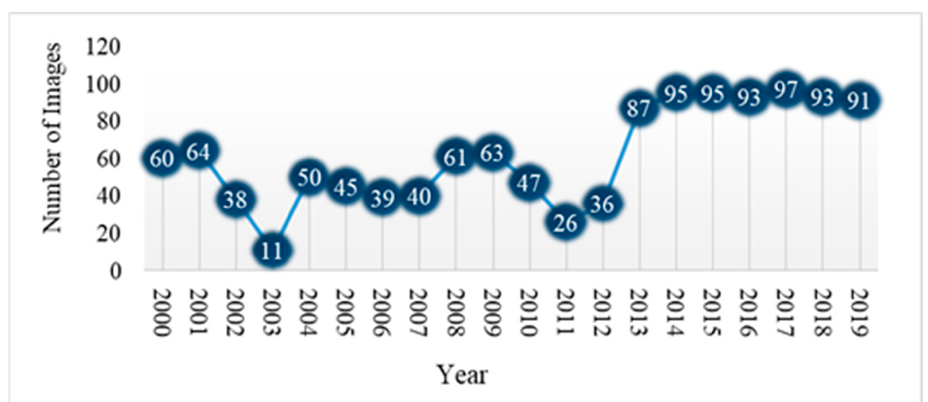
Figure A1. Number of images during study period